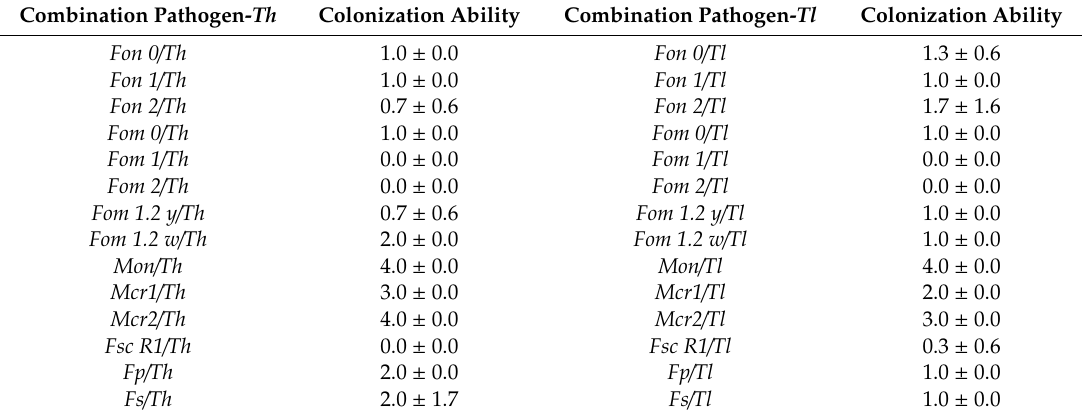
Table 3. Degree of invasion (mean ± SD of three replicates) of the 14 pathogen colonies caused by Th and Tl in dual culture, 10 days after inoculation. A visual scale with values from 0 to 4 described by Ortiz & Orduz [26] was used, in which: 0, no invasion of pathogen colony; 1, invasion of 25% of the pathogen colony surface area; 2, invasion of 50% of the pathogen colony surface area; 3, invasion of 100% of the pathogen colony surface area; 4 invasion of 100% of the pathogen colony surface area and